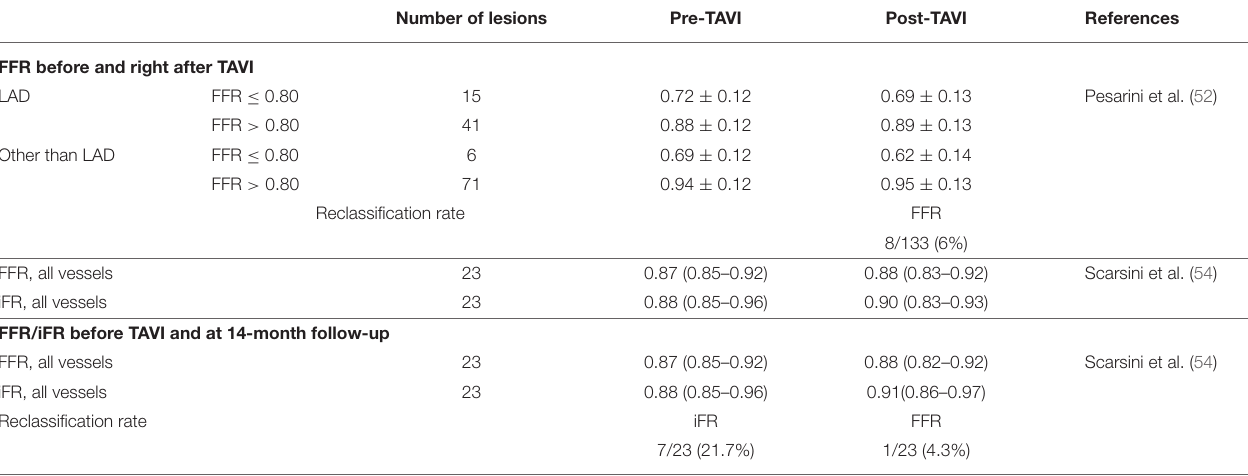
TABLE 2 | FFR and iFR measured before and right after TAVI and after 14-month follow-up. Number of lesions Pre-TAVI Post-TAVI